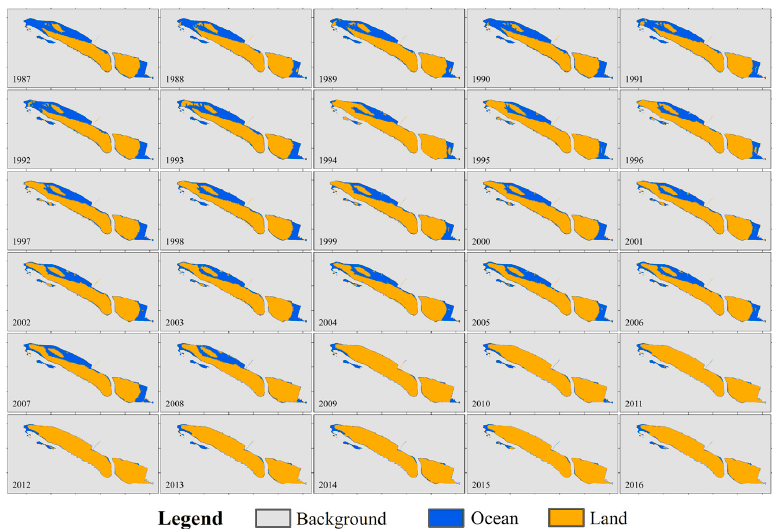
Figure 5. Spatio-temporal distributions of the estuarine islands from 1987 to 2016 with a 30-m spatial resolution and an annual scale, which show the expansion of Changxing Island and Hengsha Island. The yellow color represents land, and the blue color represents ocean. Note that land-ocean maps were limited in the area of land and dynamics ocean area. Background represents the permanent ocean area.